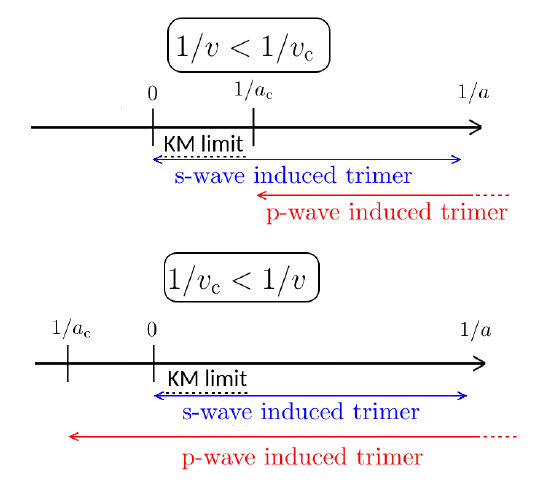
Figure 1: Domains of existence of the two types of trimers identified in this work, ≈ 8.1726, x (cid:48) < x ] . The s-wave induced trimer , shown for a mass ratio M / m ∈ [ x 1 2 c schematically in blue, is induced by the s-wave interaction between the fermions and the particle. It exists only for positive s-wave scattering lengths a > 0 and admits a universal limit (KM limit) for 1 / a → 0 + . The p-wave induced trimer , shown in red, is induced by the p-wave interaction between the fermions in presence of the s-wave interaction. It exists only for positive 1 / a > 1 / a when the p-wave inverse scattering c volume 1 / v is less than a critical value 1 / v (upper panel), and can exist for negative c 1 / a (Borromean trimer) when 1 / v > 1 / v (lower panel). Not shown in the figure: c for larger mass ratios M / m > x , there is a second s-wave induced trimer, converging 2 to the excited KM state for 1 / a → 0 + . For mass ratios M / m > x (cid:48) ,there is an excited c ≈ 13.607, there are no more KM states p-wave induced trimer. Finally, for M / m > x c for 1 / a → 0 + but an infinite number of s-wave induced trimers converging to Efimov